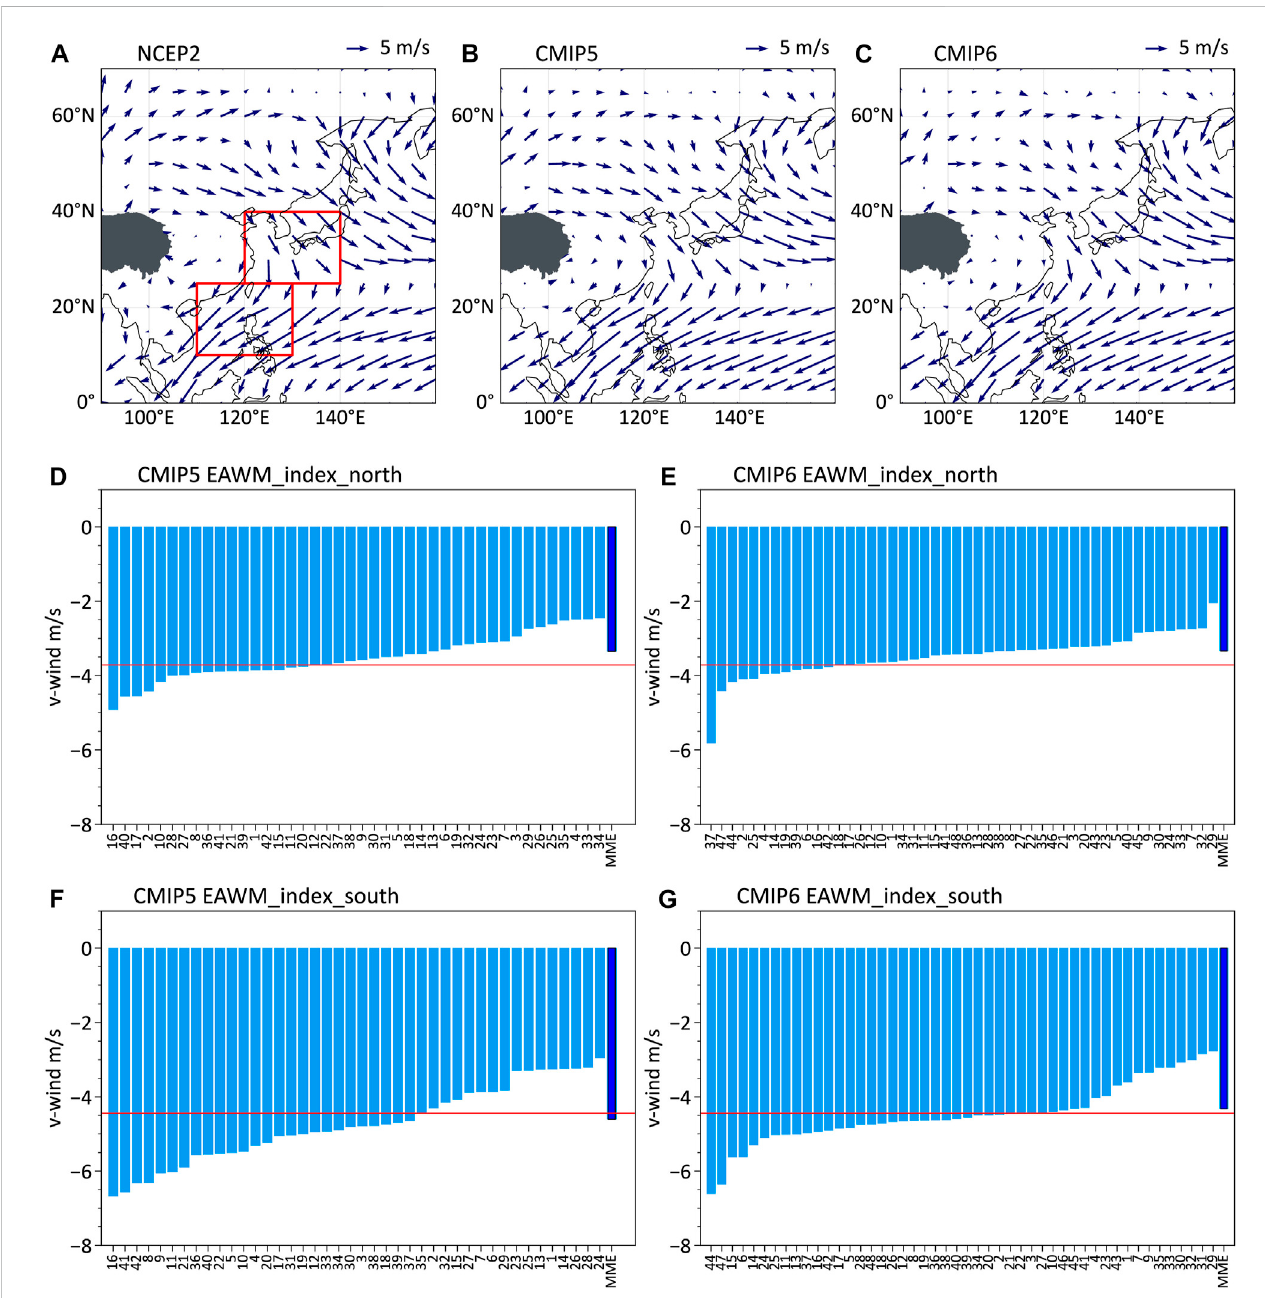
Climatologicalmeanofthehorizontalwindsat1000 hPaduringborealwinter(Dec-Jan-Feb).Thedatausedineachsubplotis (A) NCEP/DOE Reanalysis II(denotedasNCEP2)reanalysisduring1979 – 2014; (B) CMIP5MME(42models)during1979 – 2005; (C) CMIP6MME(47models)during1979 – 2014. (D,E) The northern part of the EAWM index simulated by the CMIP5 and CMIP6 models; (F, G) the same as in (D, E) , but for the southern part of the EAWM index. The northern and southern parts of the EAWM index (Chen et al., 2000) are de fi ned as the area-mean 1000 hPa meridional wind in (25 ° – 40 ° N, 120 ° – 140 ° E; upper red box) and (10 ° – 25 ° N, 110 ° – 130 ° E; bottom` red box), respectively. Red lines in (D – G) indicate the corresponding values in the NCEP2 reanalysis. The list of CMIP5/6 models is shown in Table